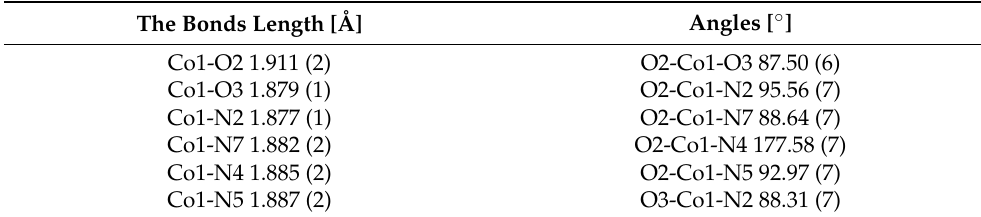
Table 2. The bonds length and Angles [ ◦ ] of Co complex.